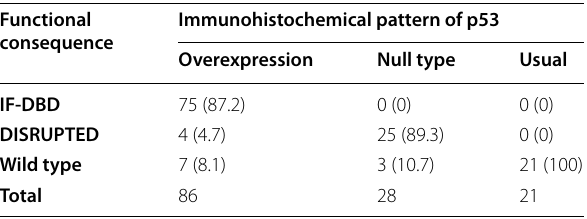
The corresponding percentages are shown in parentheses